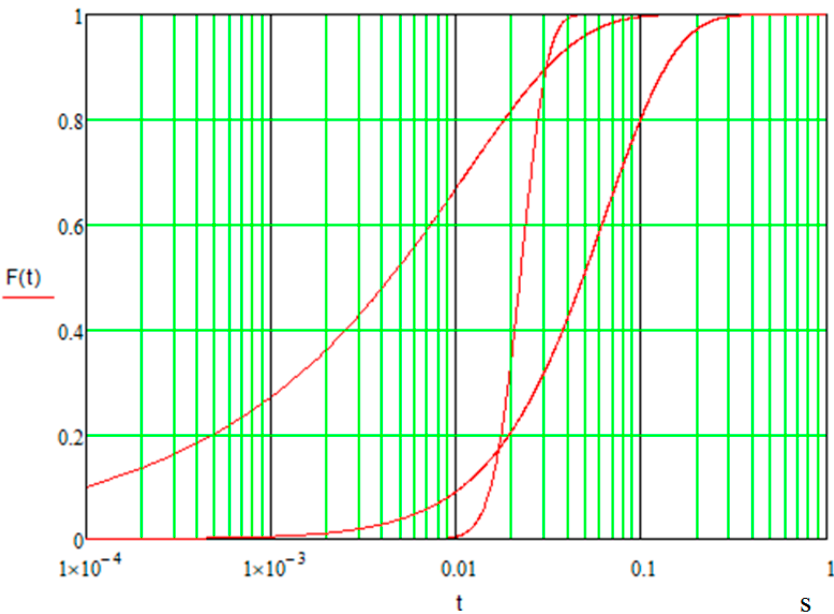
Figure 7. The graph of the distribution function of the information delivery time when (cid:2019) = 100 packets/s and there is no malefactor information impact.